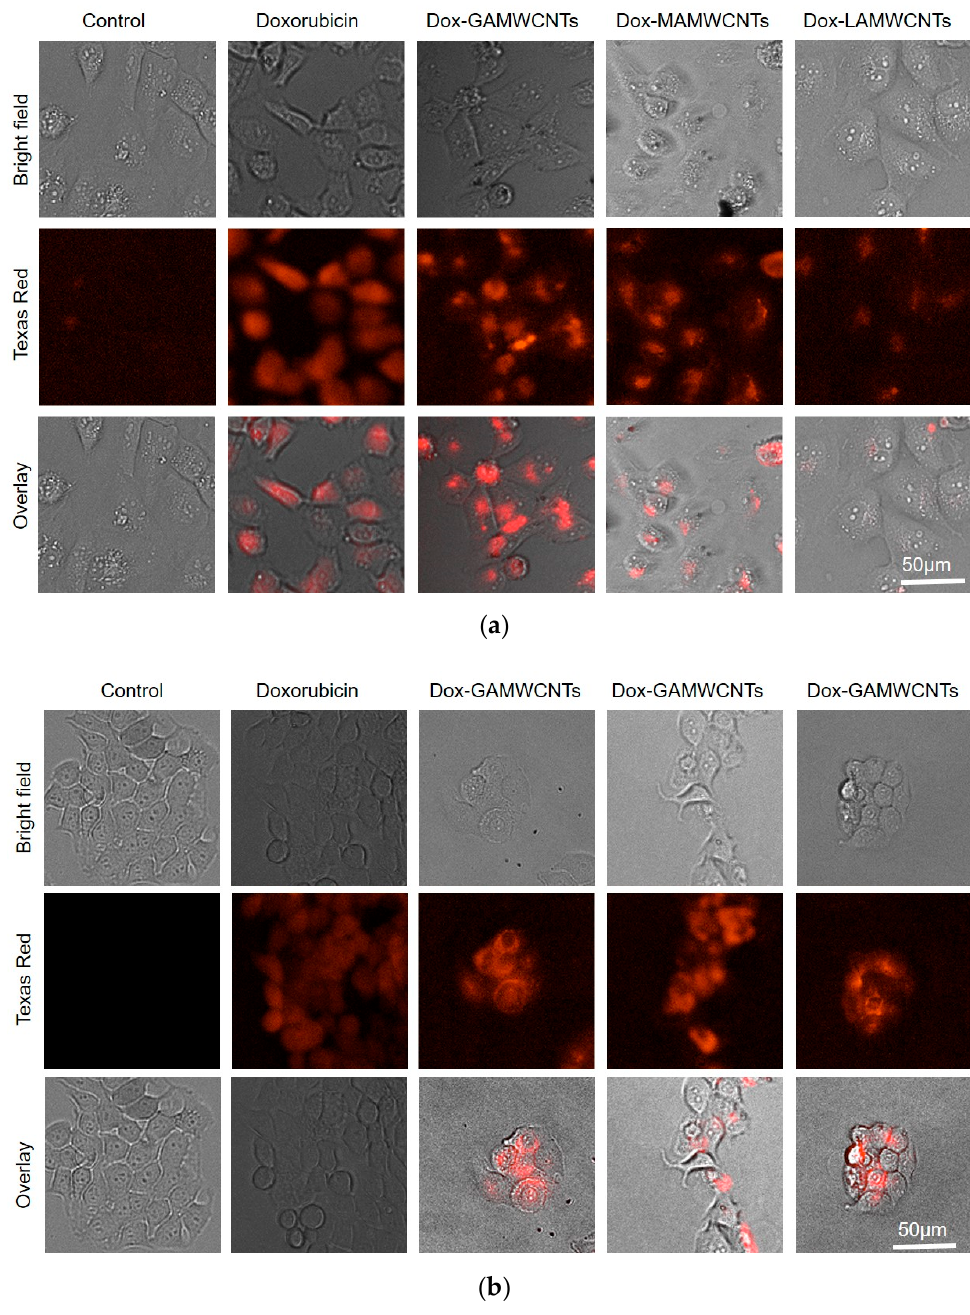
Figure 11. Fluorescence microscopy was used to determine the cellular uptake of the Dox-loaded formulations compared to pure Dox. ( a ) Representative images of the uptake of pure Dox, Dox- GAMWCNTs, Dox-MAMWCNTs and Dox-LAMWCNTs in MDA-MB-231 cells. ( b ) Representative images of the uptake of pure Dox, Dox-GAMWCNTs, Dox-MAMWCNTs and Dox-LAMWCNTs in MCF7 cells.